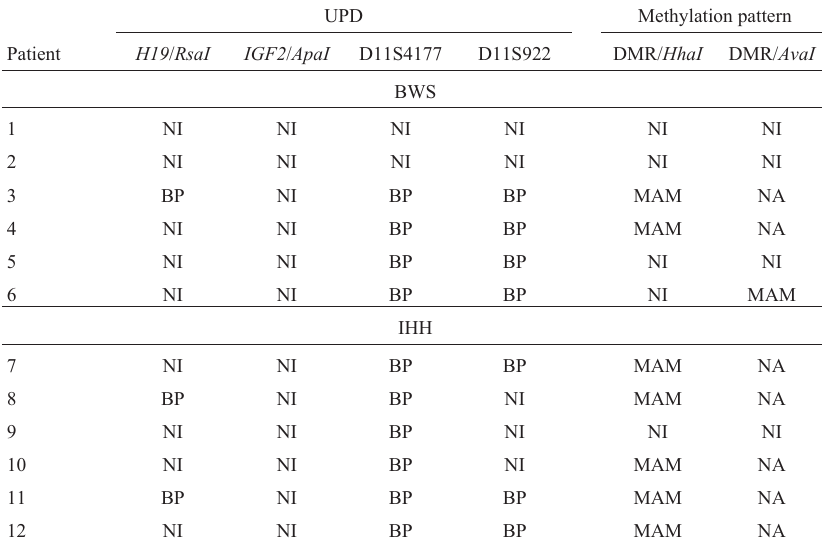
Table 1 - Summary of the investigation of uniparental disomy (UPD) and H19DMR methylation pattern in patients with Beckwith-Wiedemann syndrome (BWS) and Isolated Hemihyperplasia (IHH). UPD Methylation